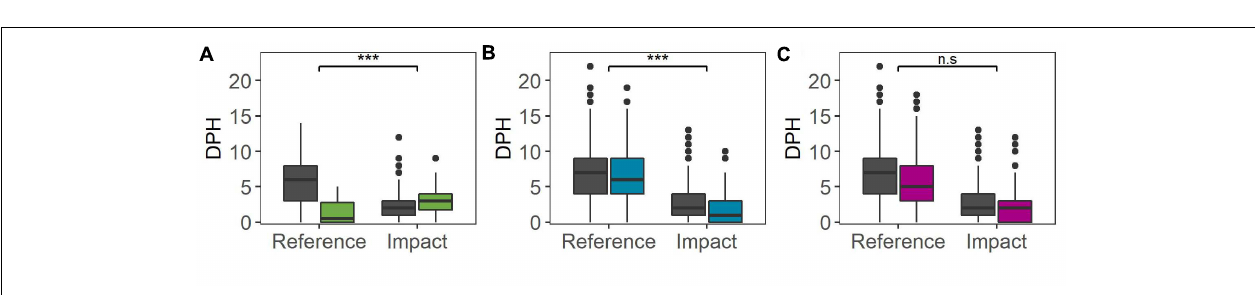
FIGURE 3 | Weekly median Detection Positive Hours (DPH) and inter-quartile ranges in the Reference Area (black) and Impact Area (gray) in each of the years studied. Colored areas indicate when offshore activities took place (green: 2D seismic survey; blue: Beatrice wind farm construction; magenta: Moray East wind farm